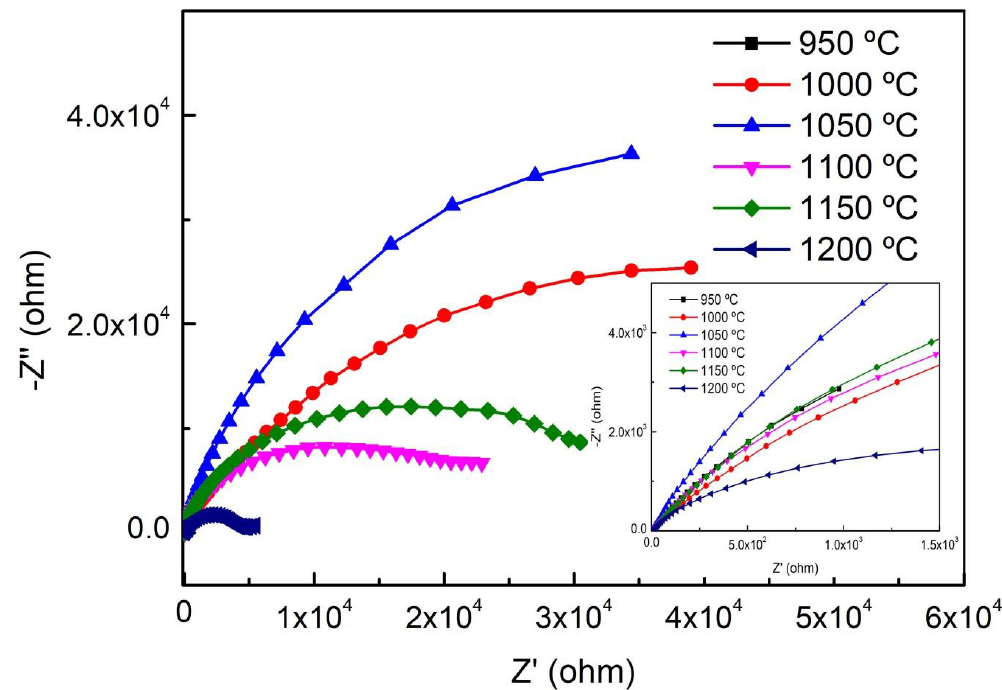
Figure 8. Nyquist curves of S32750 stainless steel at different annealing temperature.